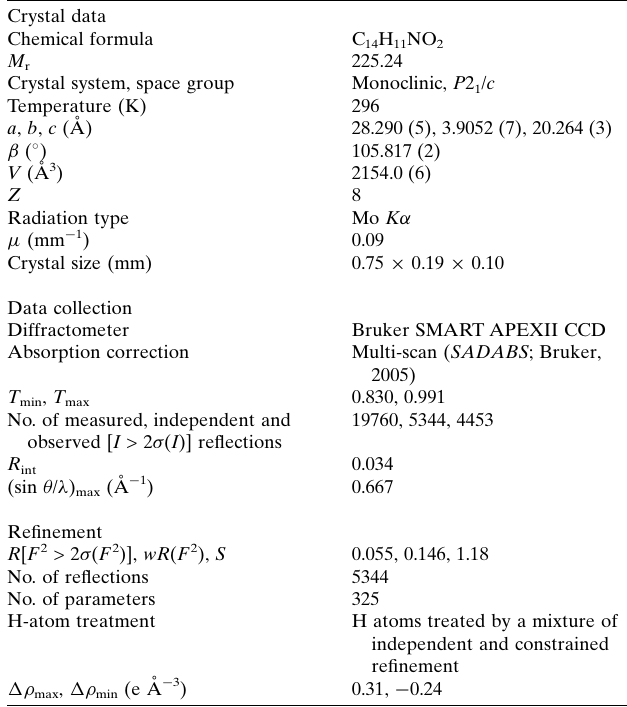
Table 2 Experimental details. Crystal data Chemical